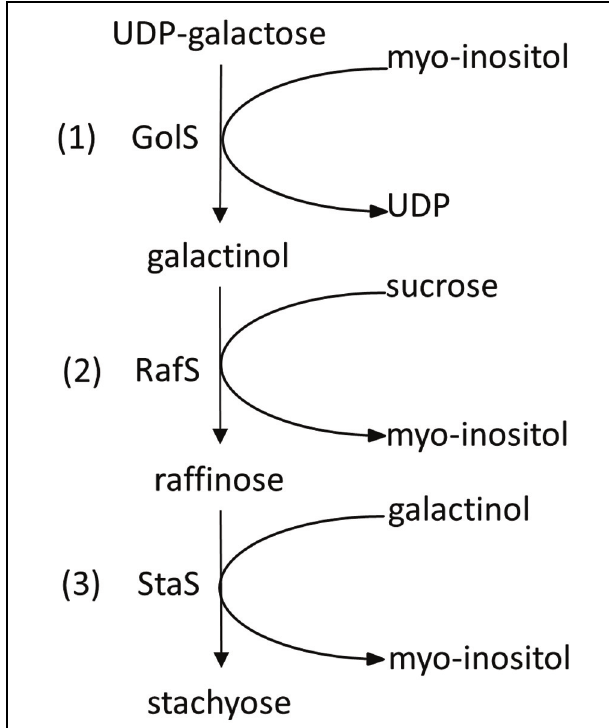
FIGURE 1 | Biosynthetic pathway of Raf and Sta in Plants. Sta biosynthesis is initiated by galactinol synthase (GolS) (1). Biosynthesis of Sta proceeds by stepwise transfer of galactosyl units involving raffinose synthase (RafS) (2) and stachyose synthase (StaS)